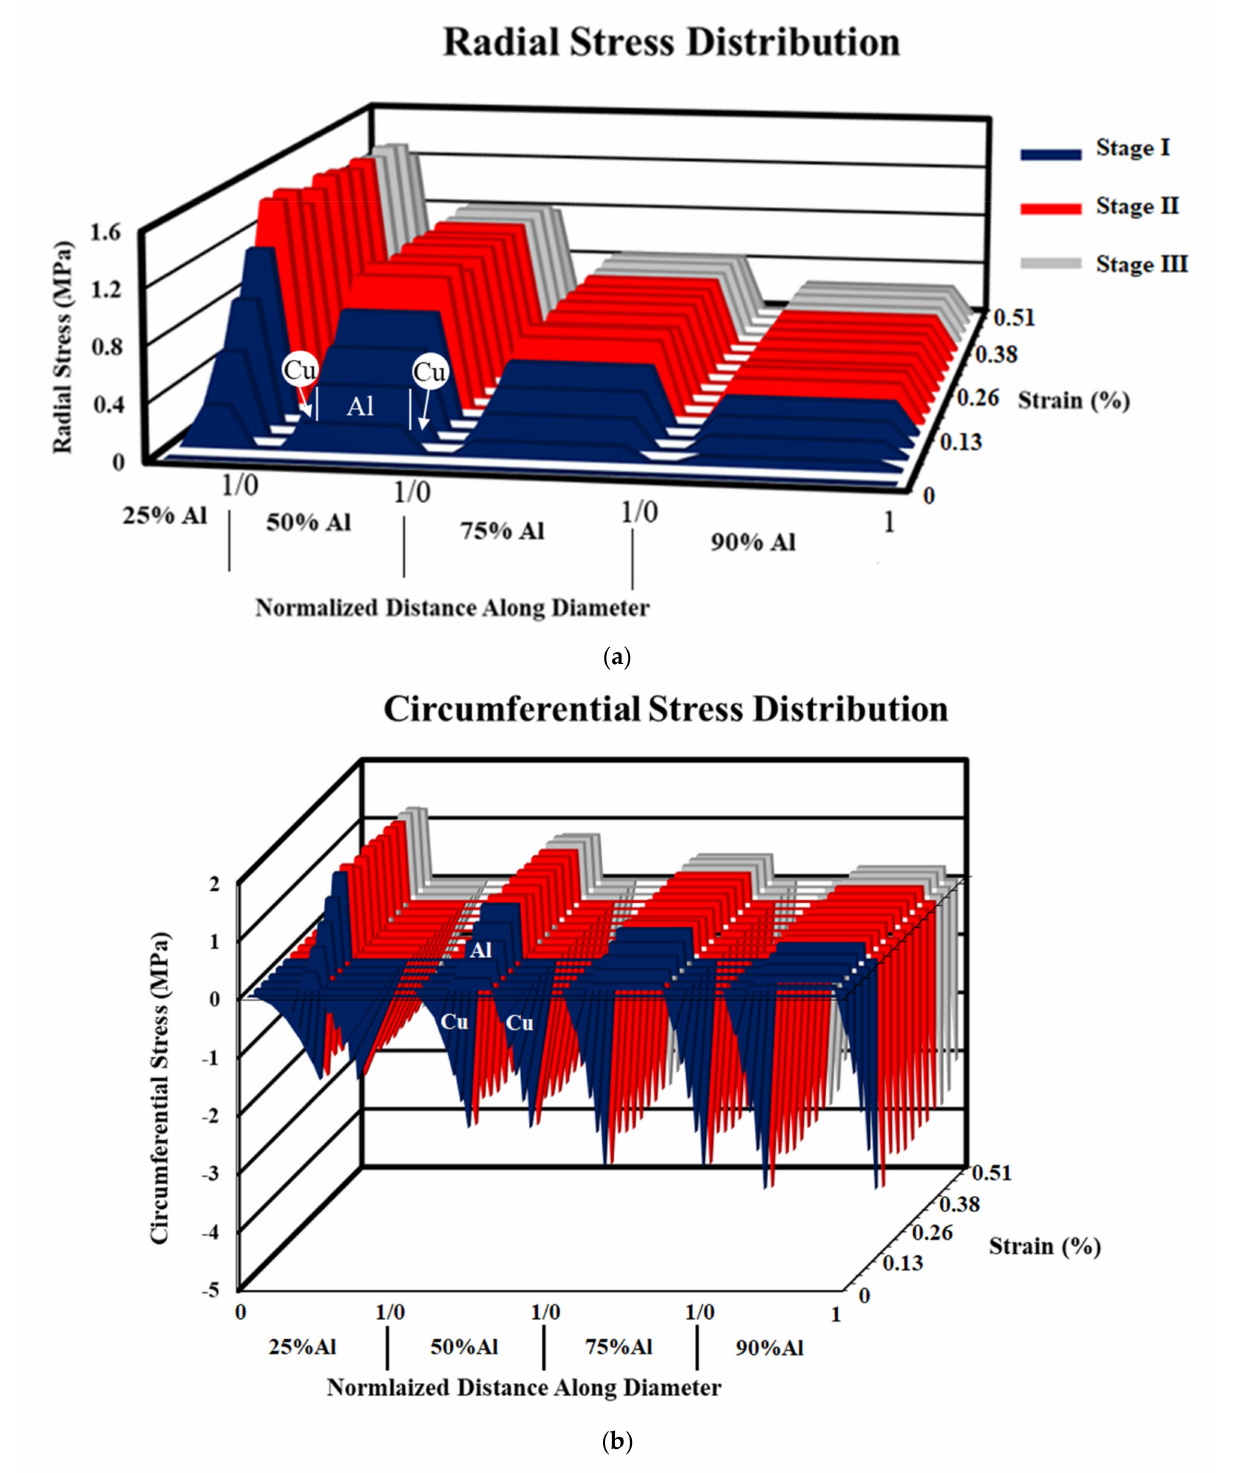
Figure 8. Development of ( a ) radial and ( b ) circumferential stresses in numerically tensile-tested CCA wires with various volume